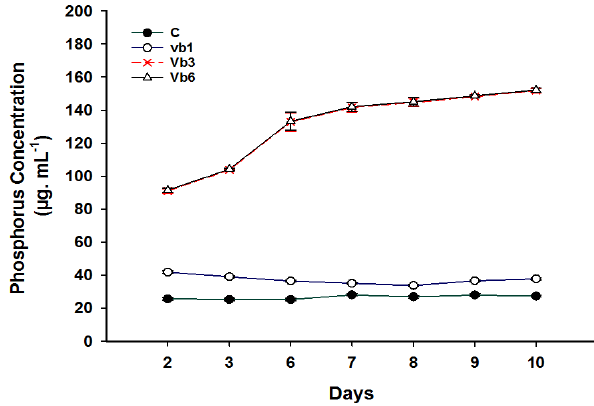
Figure 3: The amount of P-liberated by rhizospheric bacterial strains Vb1, Vb3, and Vb6 in liquid